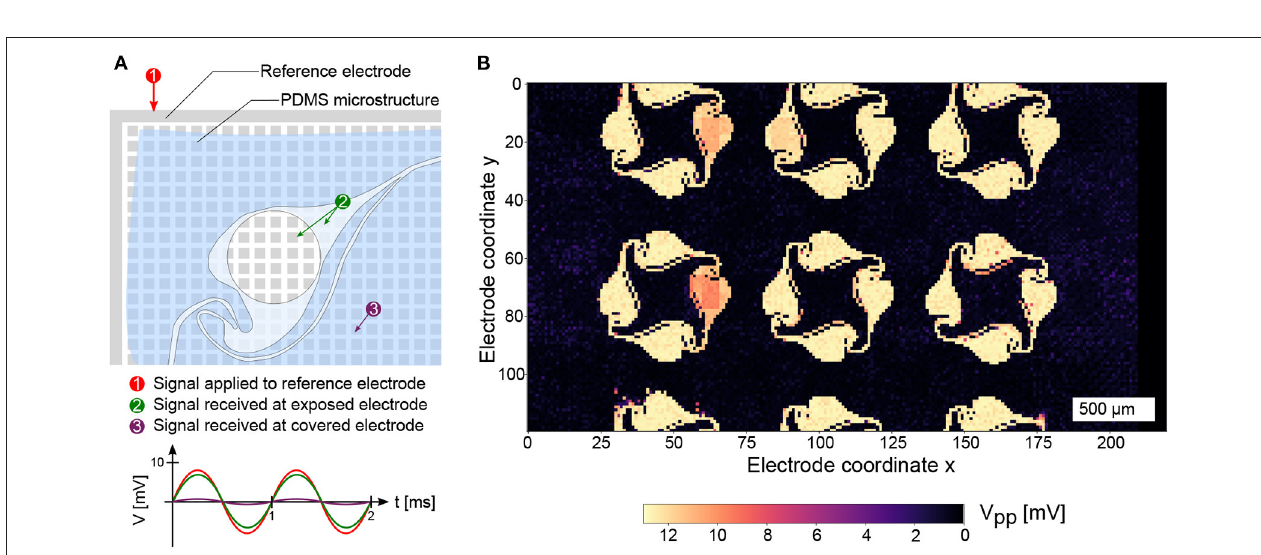
FIGURE 3 | Detection of the PDMS microstructure on the CMOS MEA. (A) Applying a sinusoidal signal on the reference electrode with an on-chip signal generator yields an undamped signal on exposed electrodes and a highly attenuated signal on covered electrodes. (B) Repeating the procedure on 25 routing patches across the MEA reveals the location and openings of the PDMS